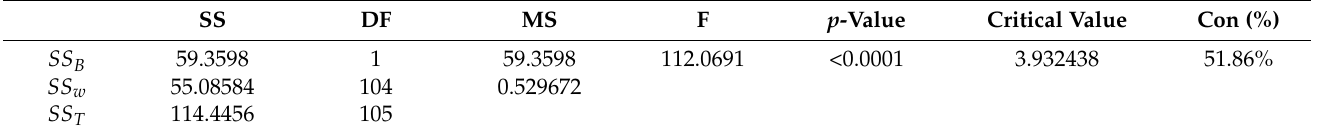
Table 7. ANOVA results for the cutting depth.